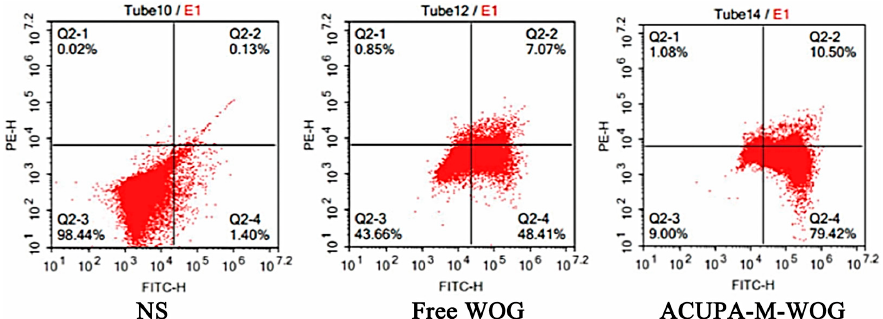
Figure 6. The apoptosis of PC-3 cells detected by Annexin V-FITC/PI stain. After treatment with normal saline (NS), free WOG (10 µM) or Chol-PEG-DUP1-M-WOG (10 µM), the PC-3 cells are stained with Annexin V-FITC/PI and the apoptosis is detected by flow cytometry.